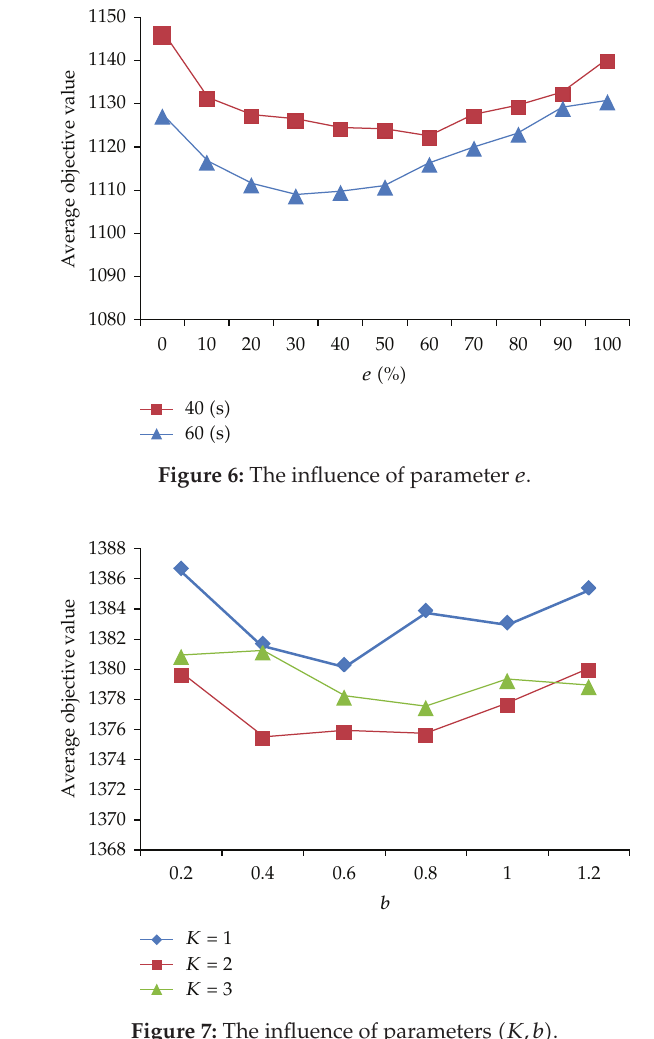
Figure 7: The influence of parameters (cid:2) K,b (cid:3)